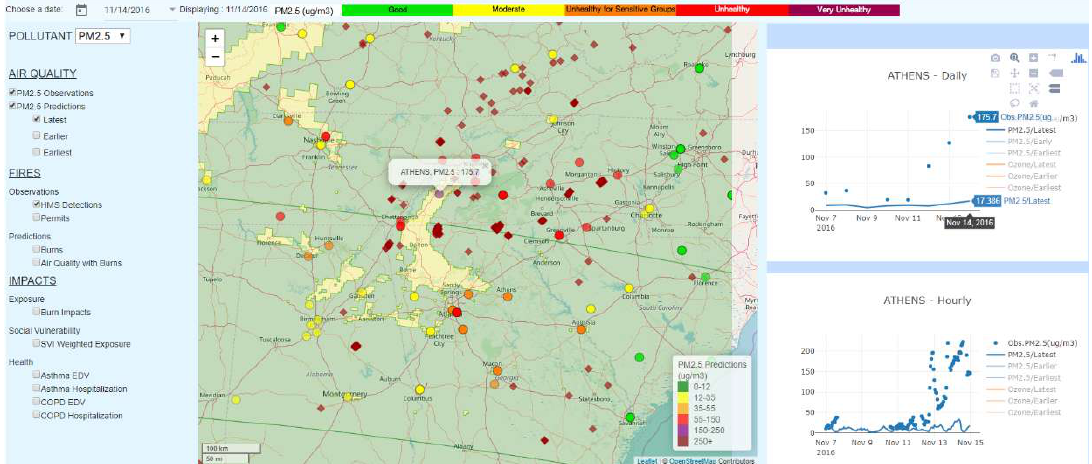
Figure 5. A potential fire‐related exceptional event that led to PM 2.5 exceedance in Athens, TN, on 14 November 2016.